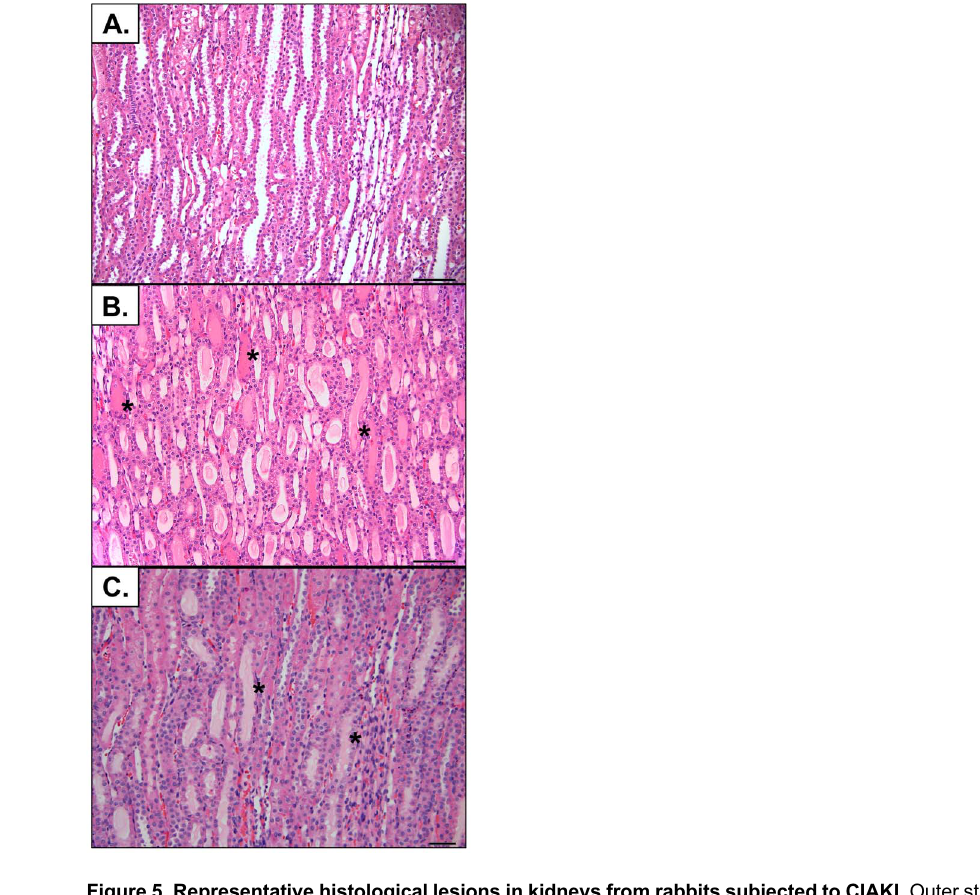
Figure 5. Representative histological lesions in kidneys from rabbits subjected to CIAKI. Outer stripe of the renal medulla from rabbits treated with (A) 2.5 g I/kg CM, (B) 10.0 g I/kg CM, or (C) 5.0 g I/kg CM and sildenafil citrate (6.0 mg/kg, q8 h). Damage consisted of intraluminal pale eosinophilic (proteinaceous) exudate. Hematoxylin and eosin stain. Original magnification 6 200; bars 5 100 m m.